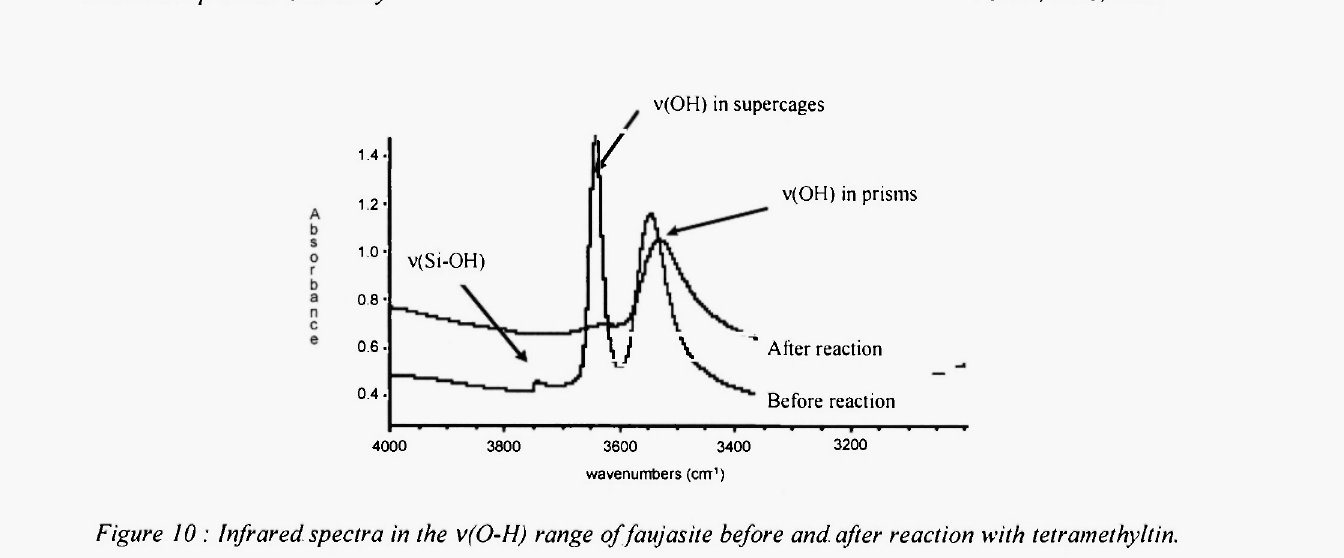
Figure 10 : Infrared spectra in the v(O-H) range of faujasite before and after reaction with tetramethyltin. Grafting reaction of tin complexes on MCM-41. Consequences on the adsorption of